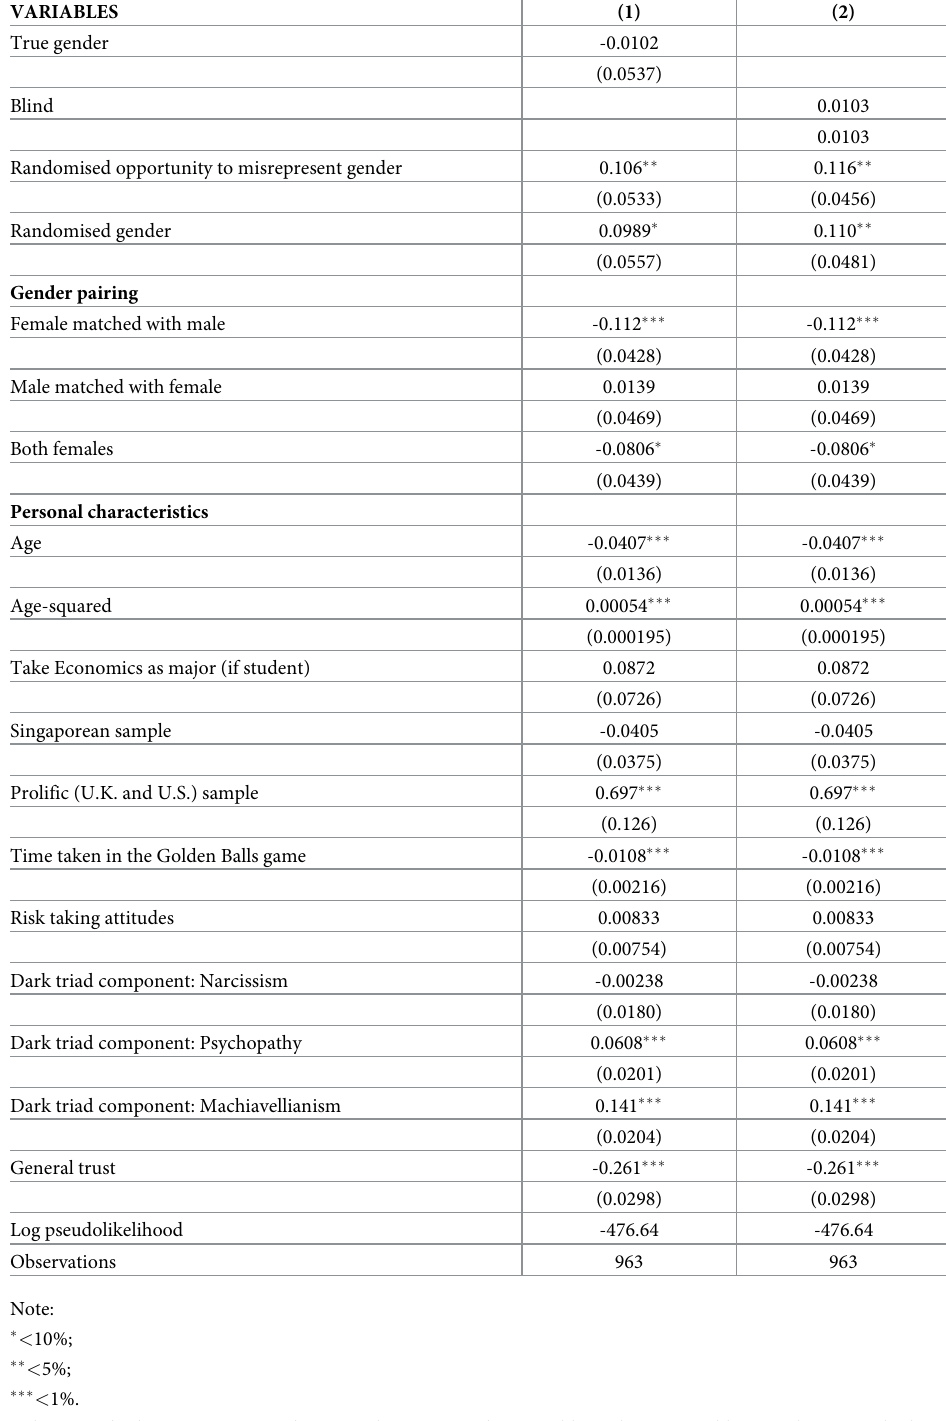
Table 2. The treatment effects on the decision to steal: Marginal effects probit